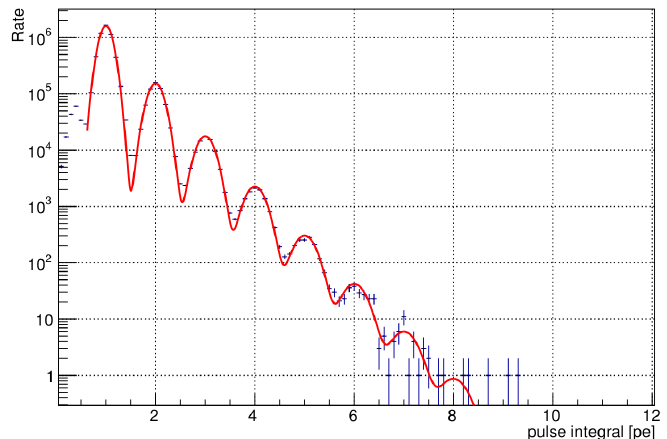
Figure 2. Single photon equivalent spectrum (blue), obtained from dark counts. Overlayed is a fit of a modified Erlang distribution (solid red line). The spectrum includes all 1440 pixels of the camera. More details in [2].